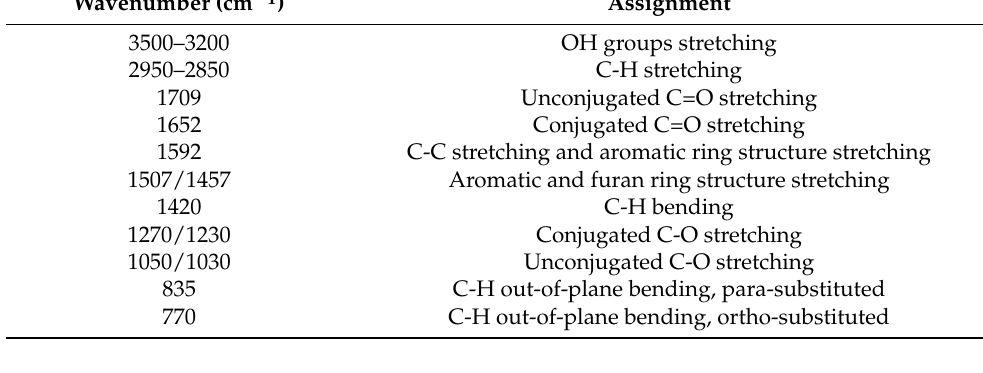
Table 6. Band Assignments for FTIR of MFP.